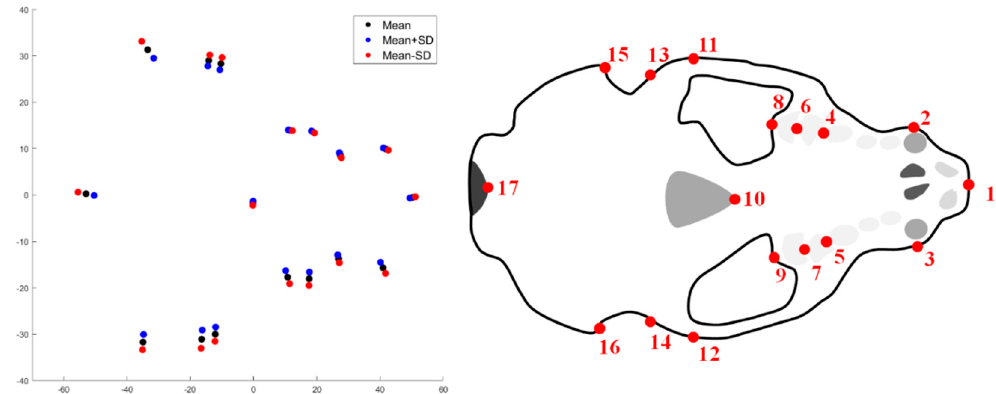
Figure 6. Sexual dimorphism in cranial size illustrated using mPCA (left-hand figure) for scaled shape data for 17 points on the bottom of the crania (schematic shown again in the right-hand figure for the sake of comparison only), which is more subtle in this case. Blue dots represent females (mean + SD) red dots represent males (mean – SD). (Note that axes are measured in mm.).